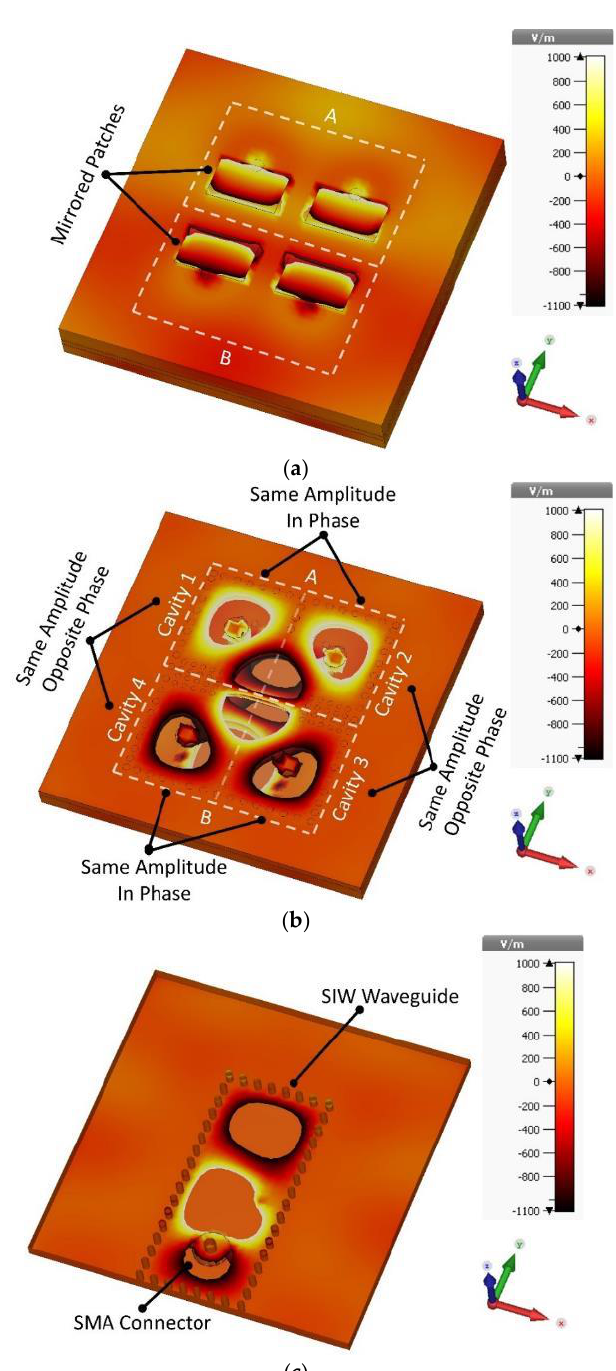
Figure 2. Simulated electric field distributions of the proposed array. ( a ) Top layer, ( b ) middle layer, and ( c ) bottom